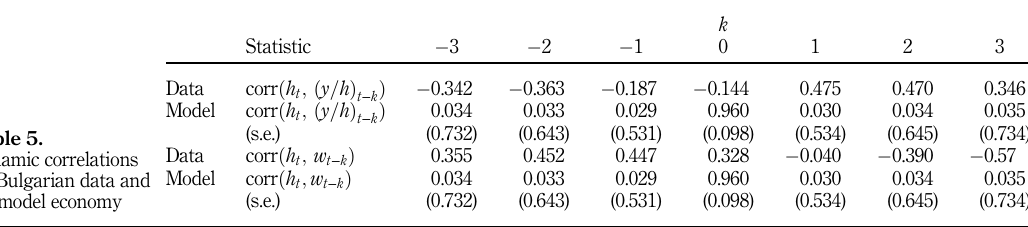
Table 5. Dynamic correlations for Bulgarian data and the model